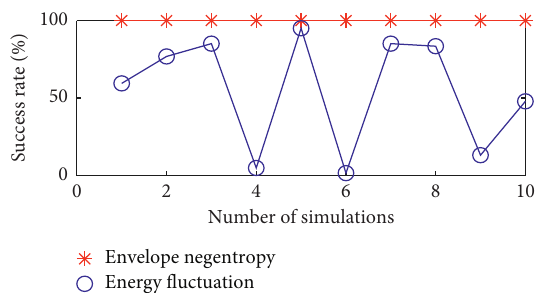
Figure 4: Success rates of the proposed method and EFS on the simulated signal in Figure 2(b).